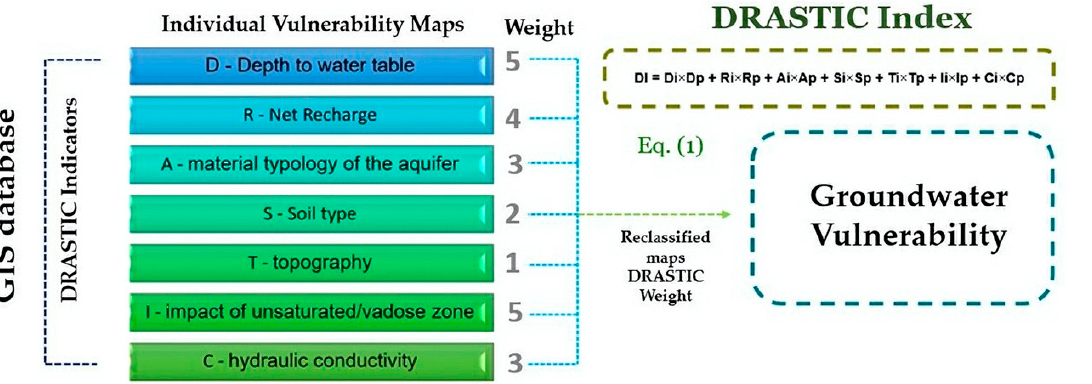
Figure 7. Flow chart of the methodology used to develop the groundwater vulnerability map using the DRASTIC model in a GIS.